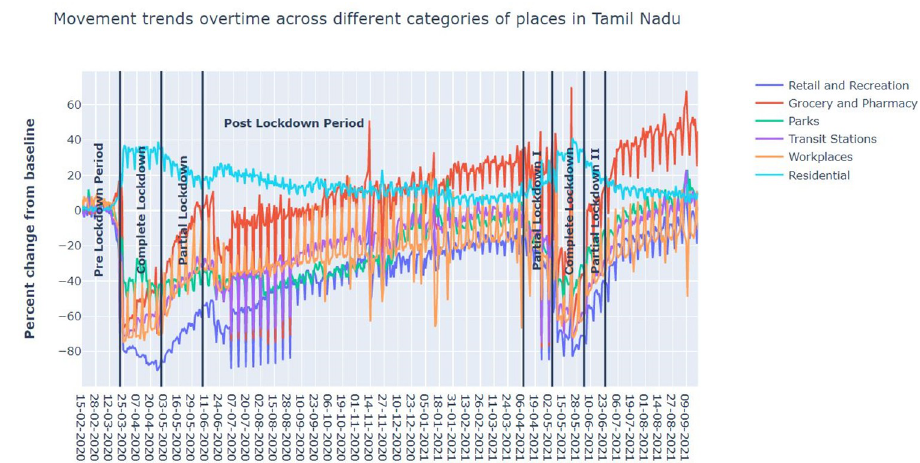
Fig 3. Graph of percentage change in mobility from baselines in six spatial domains during the first and second waves of the pandemic in 2020 and 2021. Source: Google mobility index.